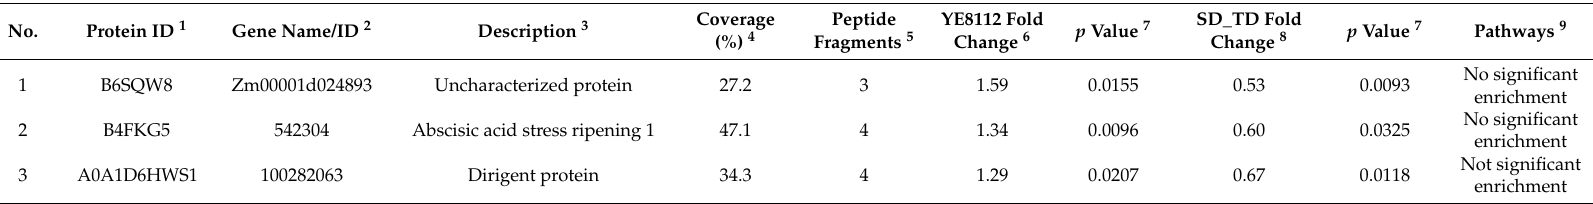
Table 4. Drought responsive DAPs of the tolerant line that were also differentially expressed between the tolerant and sensitive lines after drought treatment. No.